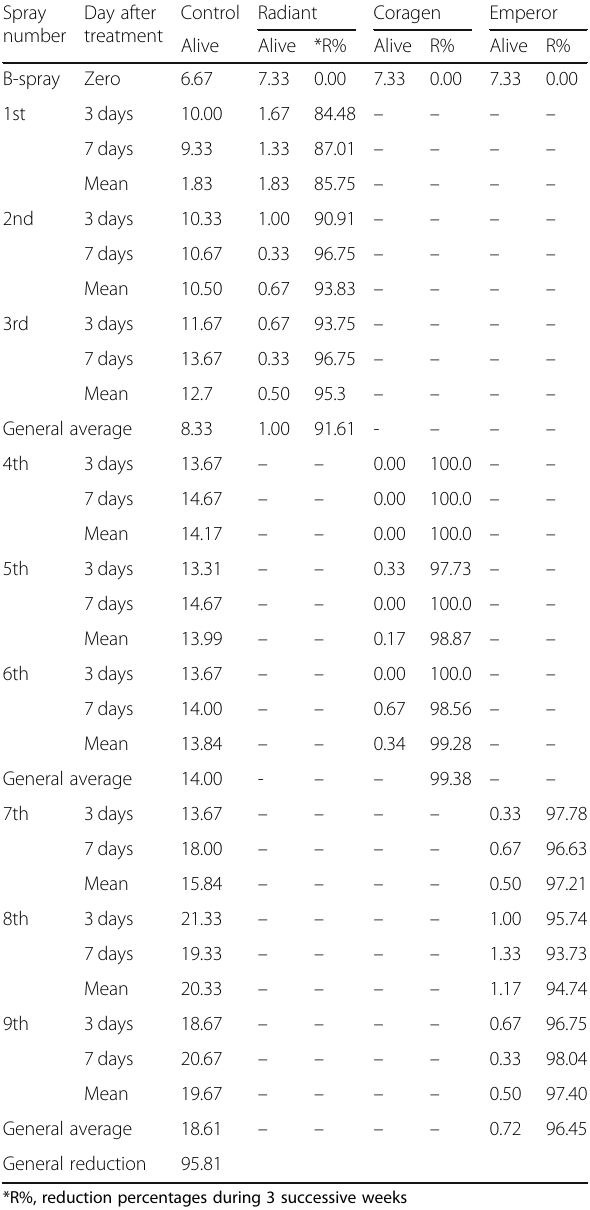
Table 4 Effect of sequential application of certain commercial non-traditional chemical insecticides on Tuta absoluta applied three times (during vegetative stage) Spray Day after Control number treatment